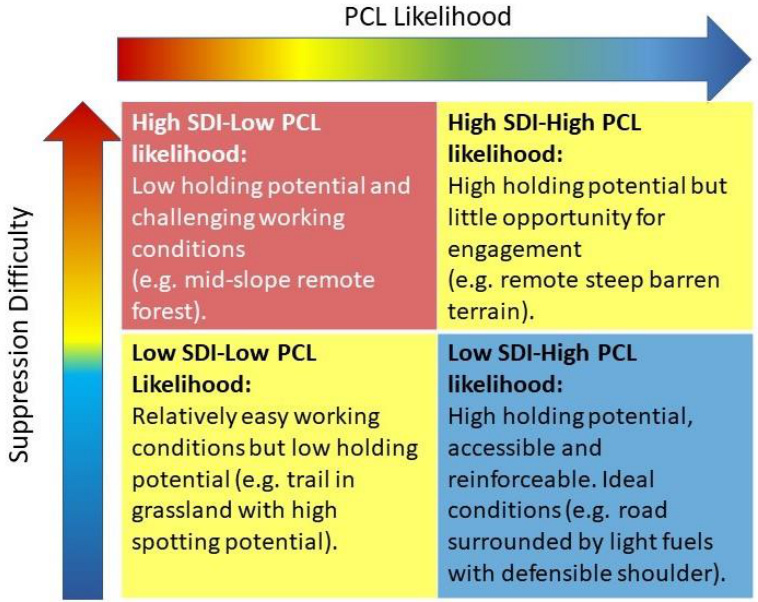
Figure 3. SDI-PCL matrix. The color codes applied to SDI and the PCL atlas are designed to complement one another. Locations where the products agree represent the best (blue/blue) or worst (red/red) conditions for safe and effective wildfire response actions. Locations where the products diverge indicate conditions where there is a juxtaposition between suppression effort and containment likelihood.